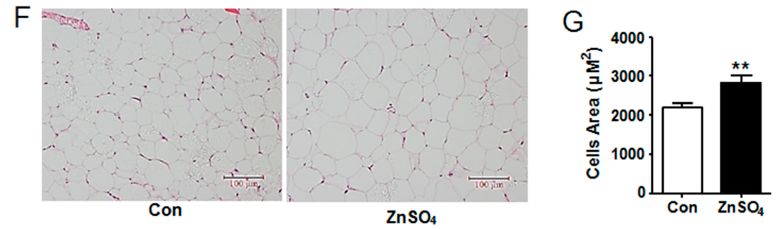
Figure 2. Chronic zinc supplementation induced visceral adipose tissue hypertrophy. ( A ) Body weight ( N = 8 for each group); ( B ) The weight of perirenal adipose tissue ( N = 8 for each group) ( P = 0.0143); ( C ) The weight of epididymal adipose tissue ( N = 8 for each group); ( D ) H&E staining images for